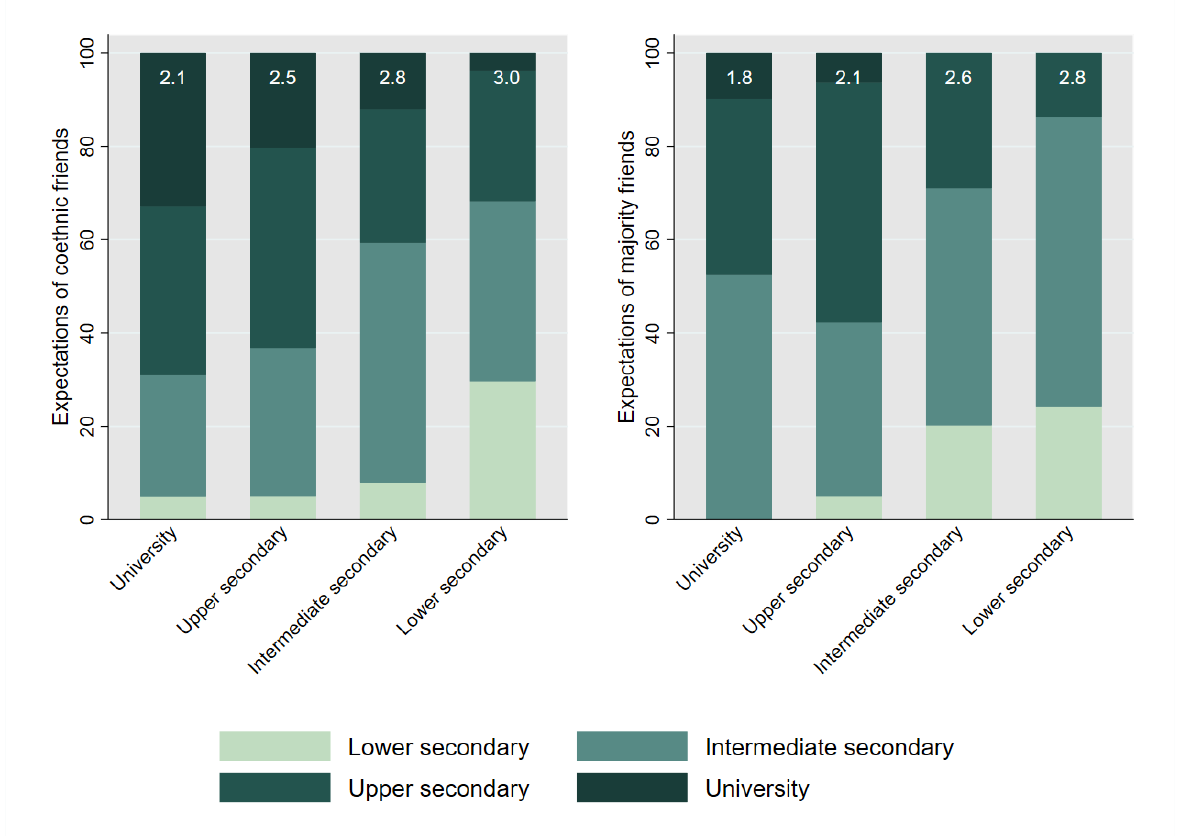
Figure 1: The relationships between Turkish-minority adolescents’ educational expectations (categories on the x axis) and that of their coethnic friends (left panel) and majority friends (right panel). Notes: The white numbers within the bars indicate the average educational expectations of the particular subgroup of friends. Sources: CILS4EU, authors’